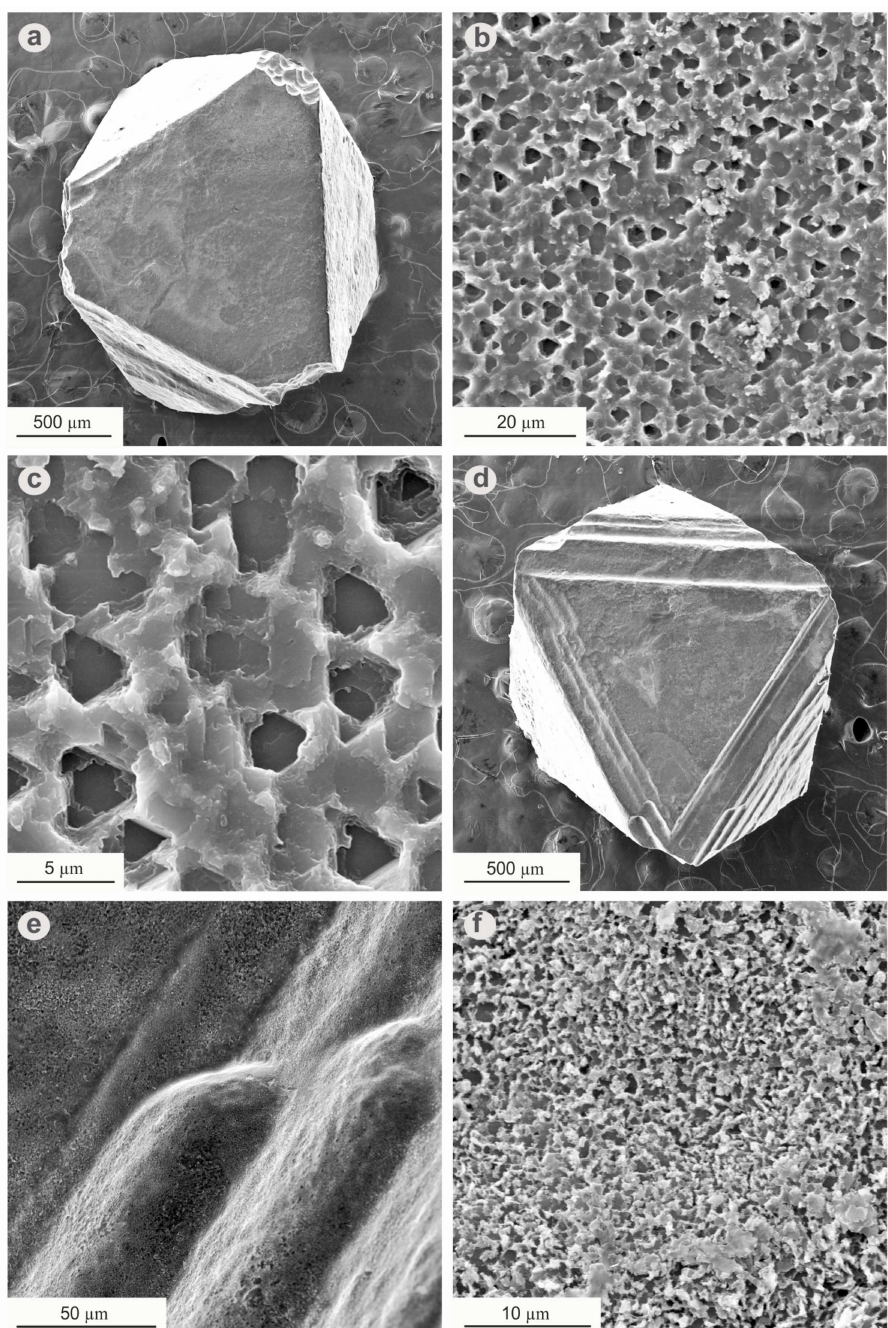
Figure 4. Diamond crystals etched at 1130 ◦ C in a basaltic melt, under the HM buffer, for 3.5 h ( a – c ) and under the NNO buffer for 2.5 h ( d – f ). ( a ): general view; ( b , c ): fragments of an octahedral face with trigonal, truncated trigonal, and hexagonal pits; ( d ): general view; ( e ): preserved growth steps; ( f ): dissolution sculptures on an octahedral face resulting from surface